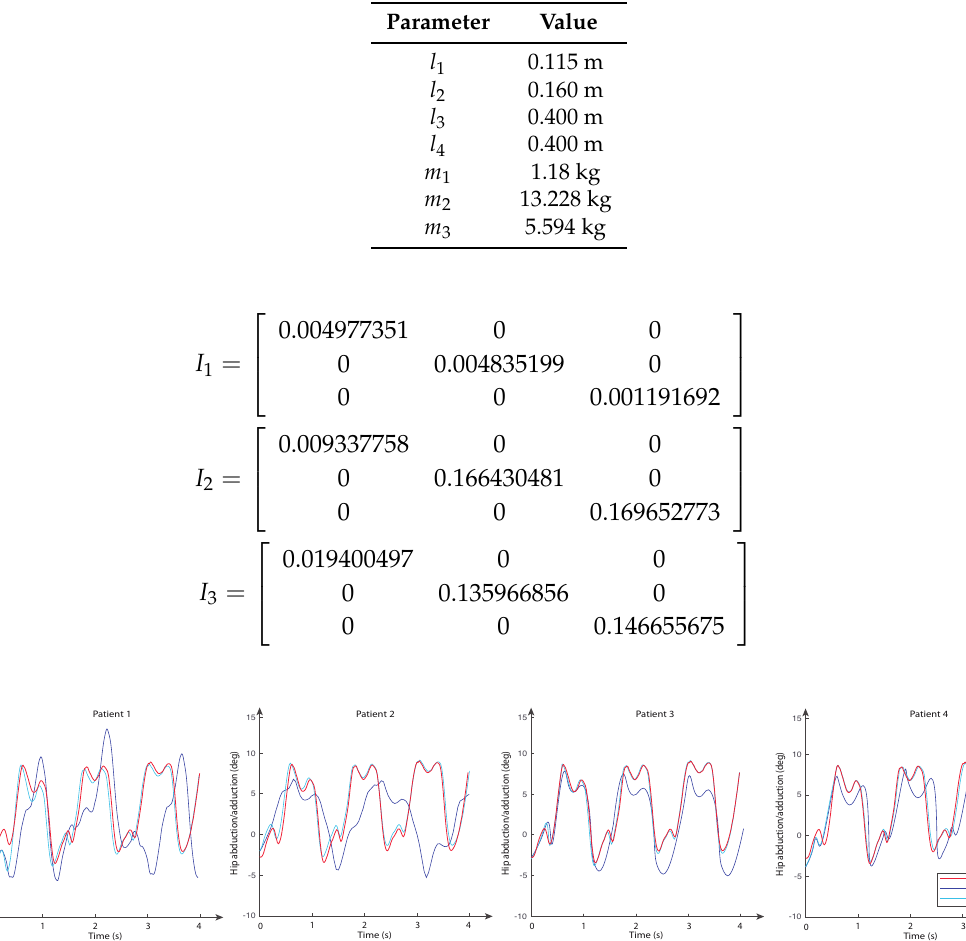
Figure 11. Hip abduction/adduction angles for a normal subject (reference signal) and four subjects with multiple sclerosis for both open loop and using the PD adaptive controller.